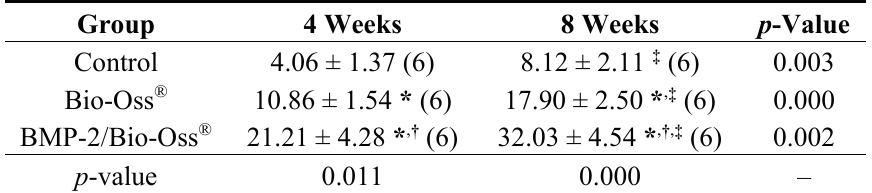
Table 2. The total volumes (%) of newly formed bone in the control, Bio-Oss ® , and rhBMP-2 groups (means ± SD (number of